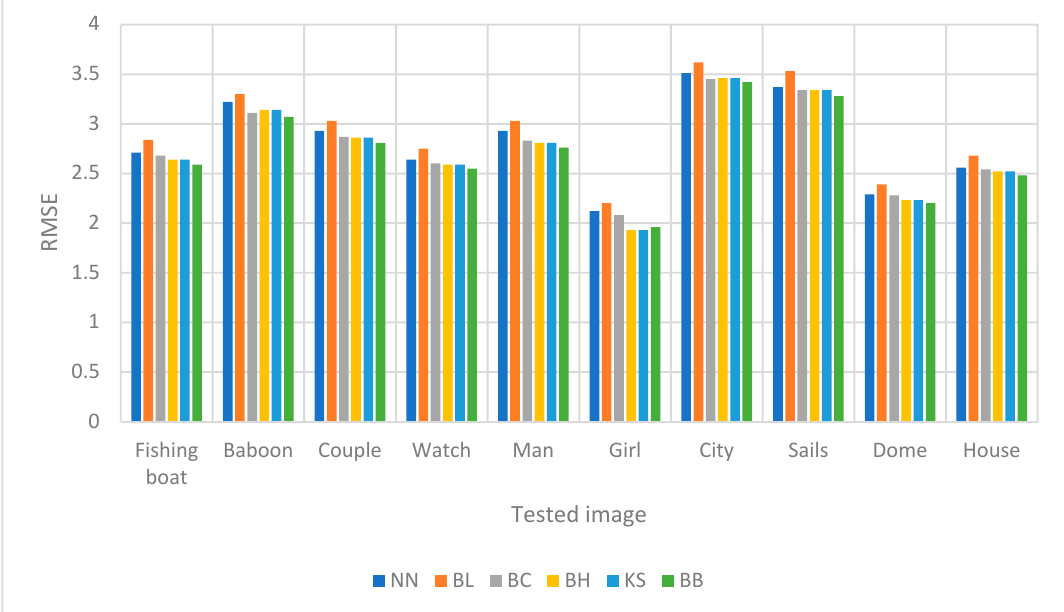
Figure 9. A comparison of schemes toward RMSE for image upscaling with a factor of two.